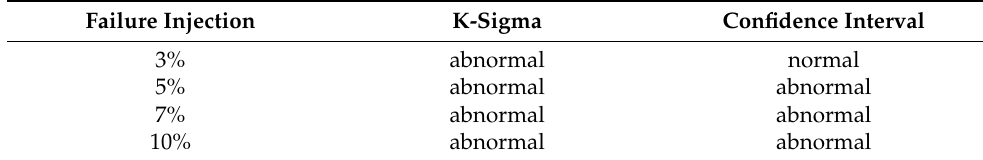
Figure 9. ( a ) The model with K-sigma in 3% fault injection. ( b ) The model with Confidence interval in 3% fault injection. Table 3. Prediction accuracy of GRU under different windows.